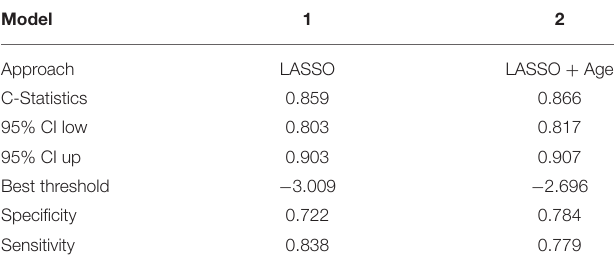
TABLE 3 | Comparison of the two